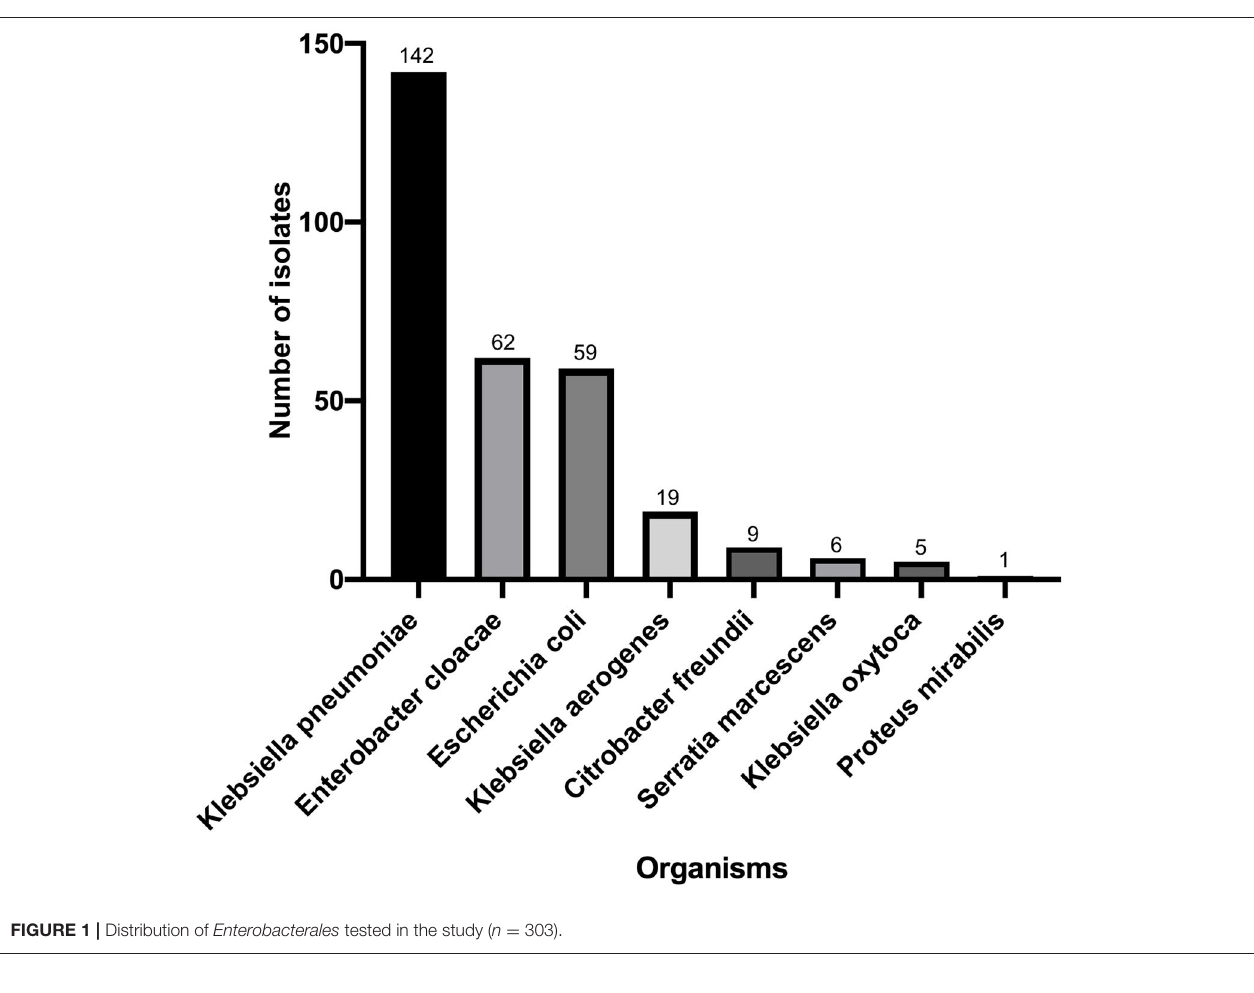
FIGURE 1 | Distribution of Enterobacterales tested in the study ( n = 303).